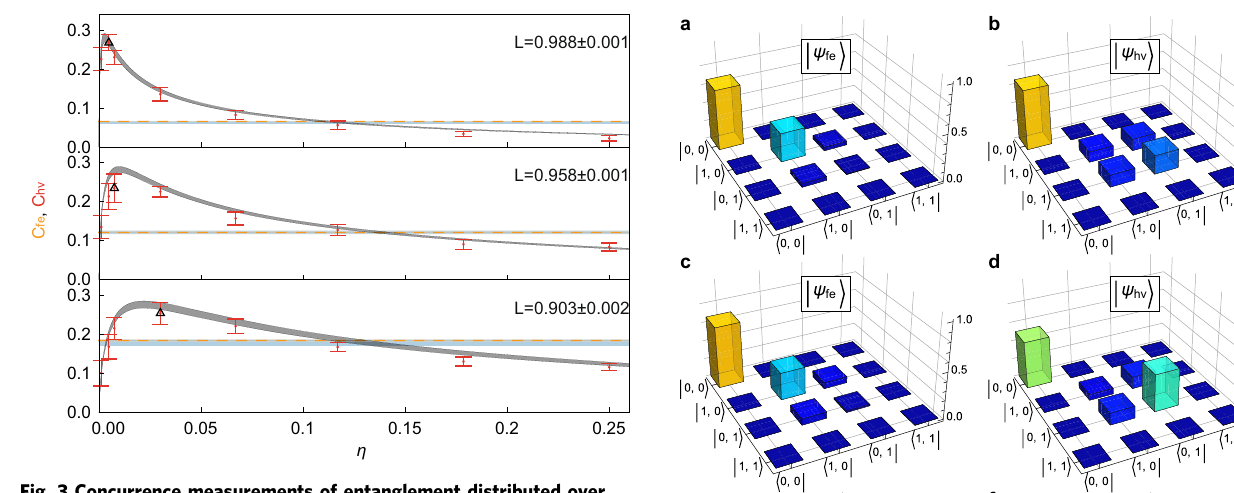
Fig. 3 Concurrence measurements of entanglement distributed over different types of channels for three different values of added loss L on mode “ e ” . Orange lines and blue shaded areas correspond to the experimentally measured and theoretically predicted concurrence C fe of (cid:1) (cid:3) (cid:1) ψ state distributed directly through loss. Red dots and gray shaded areas fe correspond to the experimentally measured and theoretically predicted concurrence C hv of entanglement distributed via the error-corrected quantum channel Fig. 1d, with the same amount of loss and the same input (cid:1) (cid:3) (cid:1) state ψ . Black triangles highlight data points with maximum observed fe increase in concurrence. The upper and lower bounds for the theoretical predictions correspond to the lowest and highest observed transmissions for each mode inside the experimental setup, respectively. Error bars and shaded areas on orange lines correspond to the experimentally observed statistical uncertainty of ± 1 standard deviation.